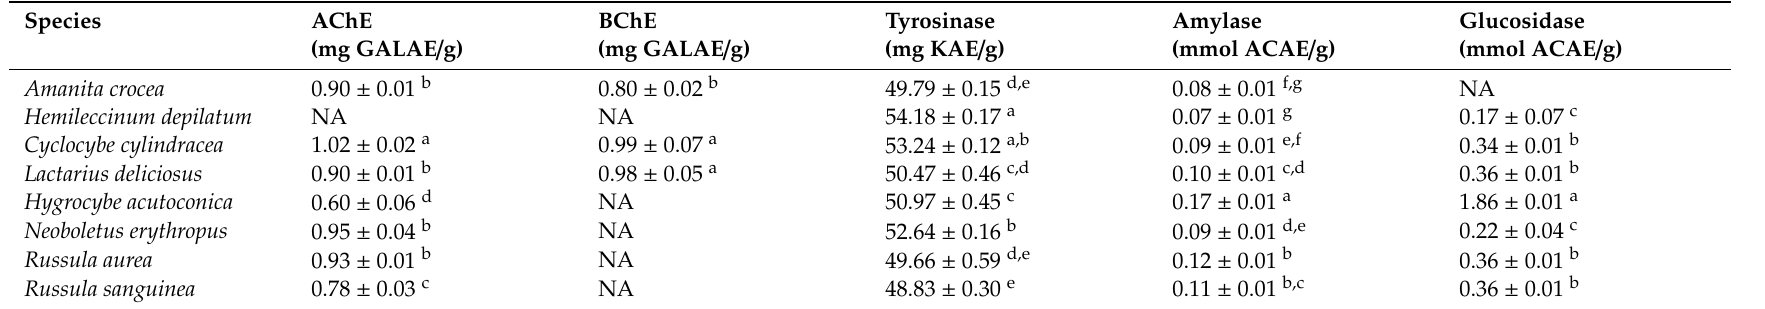
Table 4. Enzyme inhibitory properties of the tested mushroom extracts